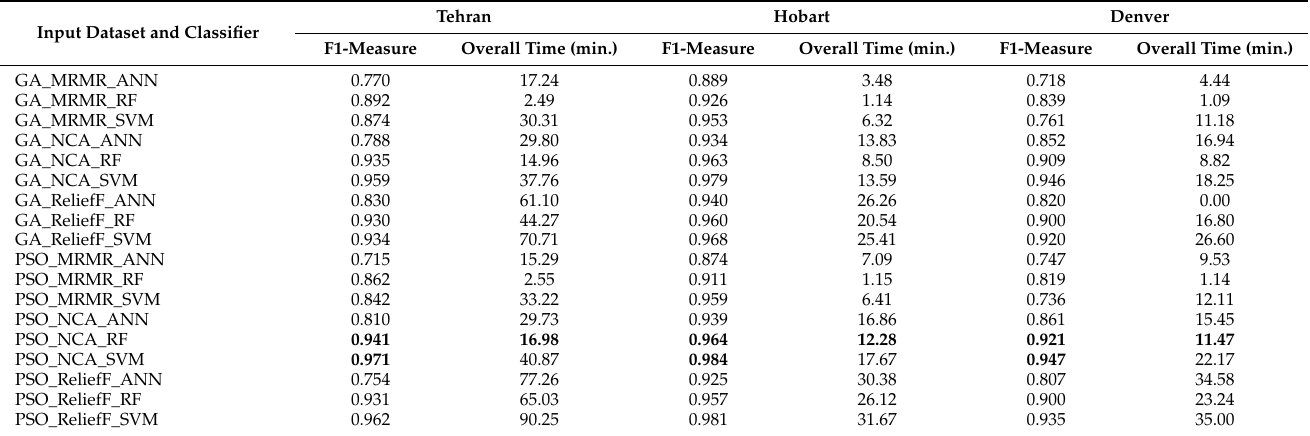
Table 2. F1-measure values and overall time (the sum of classification and filter-based process time) for classifying 14 qualified features in Tehran, Denver, and Hobart